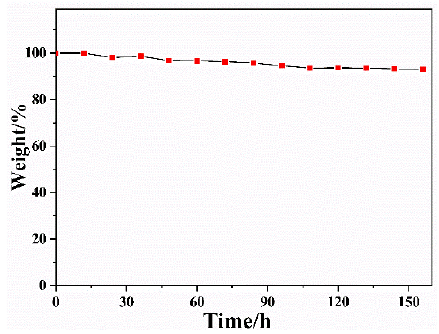
Figure 5. Fenton test of PPI membranes.